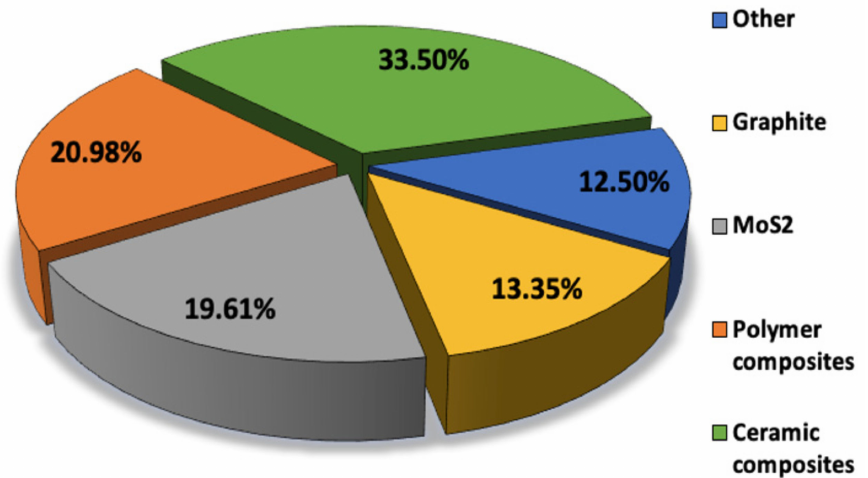
Figure 2. The pie chart shows the research conducted on different solid lubricants from 2000 to